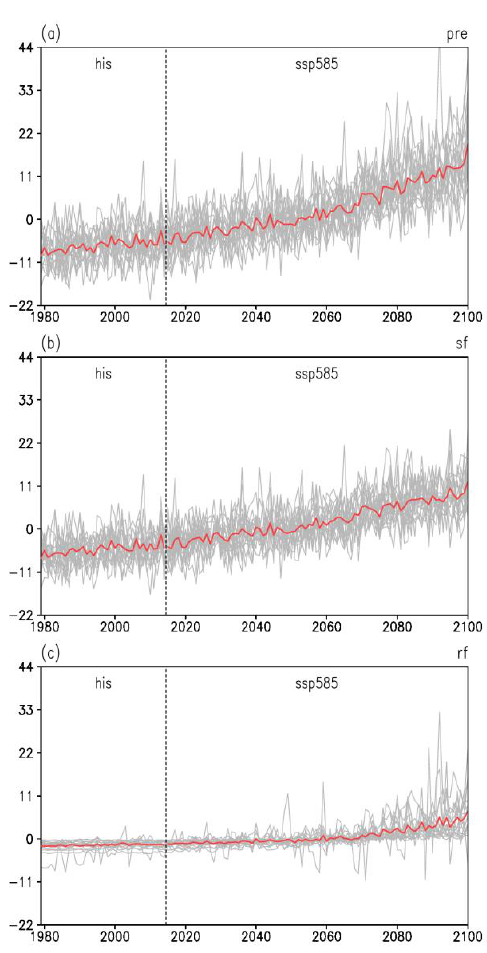
Figure A1. Time series of area-mean NDJF ( a ) precipitation (pre, mm month −1 ), ( b ) snowfall (sf, mm month −1 ), and ( c ) rainfall (rf, mm month −1 ) anomalies of each model (gray line) and multi- model ensemble (red line) for the period 1979–2100 with historical forcing until 2014 and projections under SSP585 scenarios during 2015 – 2100 in east Siberia.